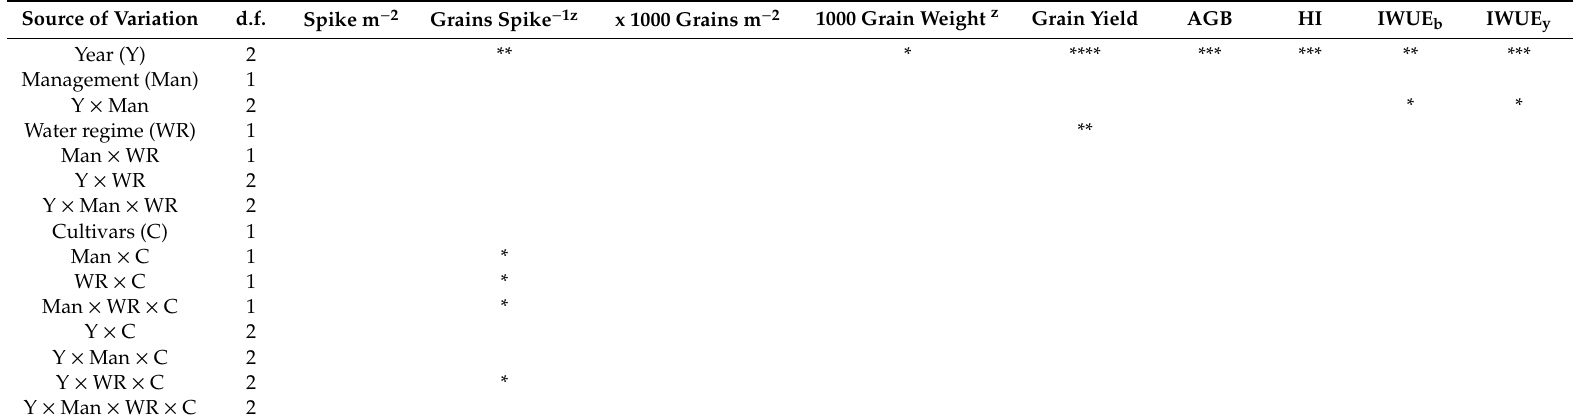
Table 6. Significance levels of analysis of variance over 2012–2013, 2013–2014 and 2014–2015 for the barley experiment. Source of Variation